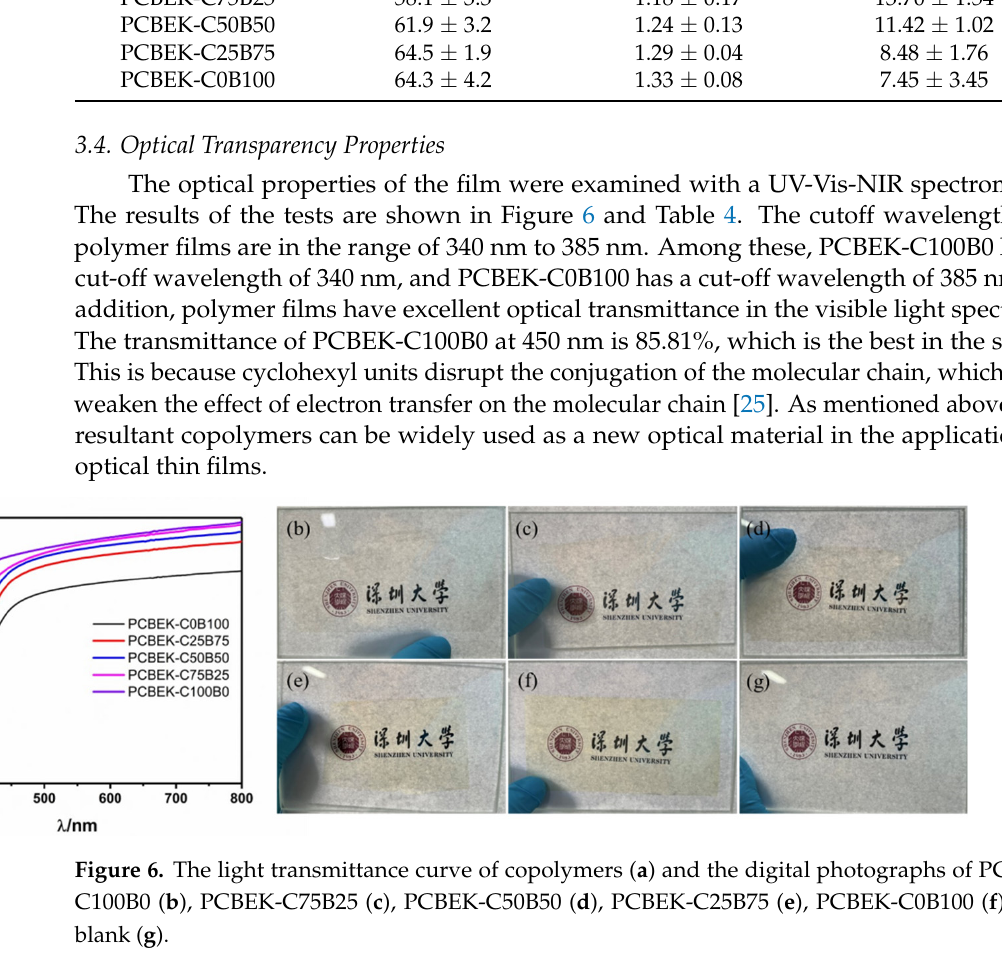
Table 3. Mechanical property parameters of copolymer PCBEKs films.